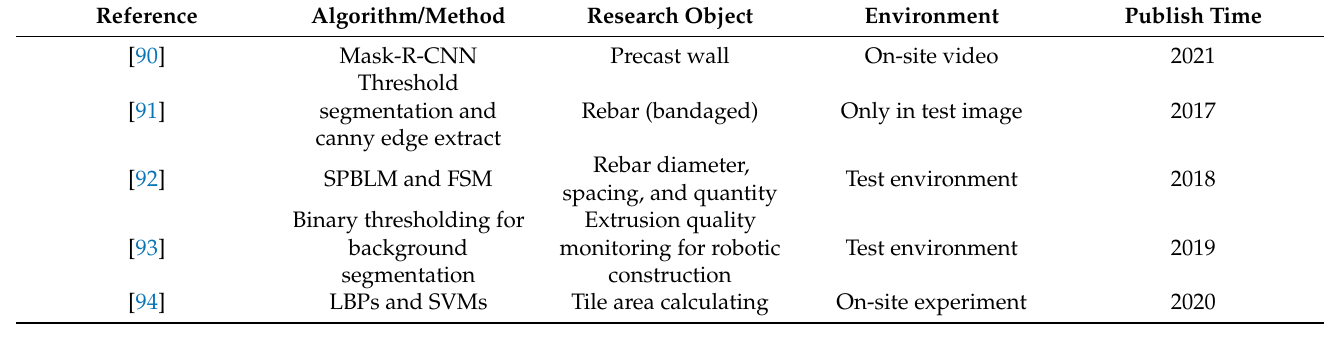
Table 4. Computer vision applications in materials.